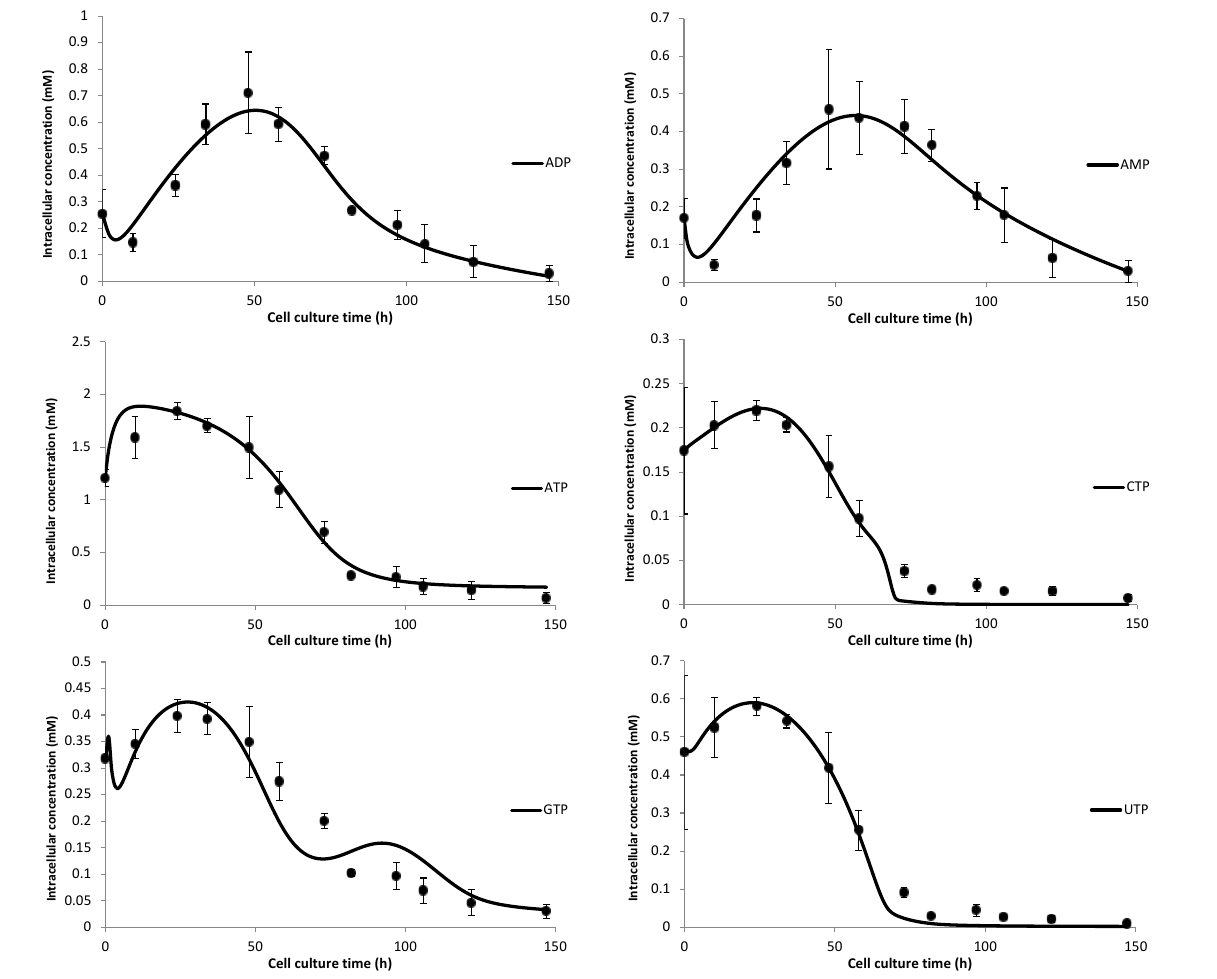
Figure 5. Experimental data compared with generated fits from the nucleotide model. Fits for intracellular ADP concentration ( top left ), intracellular AMP concentration ( top right ), intracellular ATP concentration ( center left ), intracellular CTP concentration ( center right ), intracellular GTP concentration ( bottom left ) and intracellular UTP concentration ( bottom right